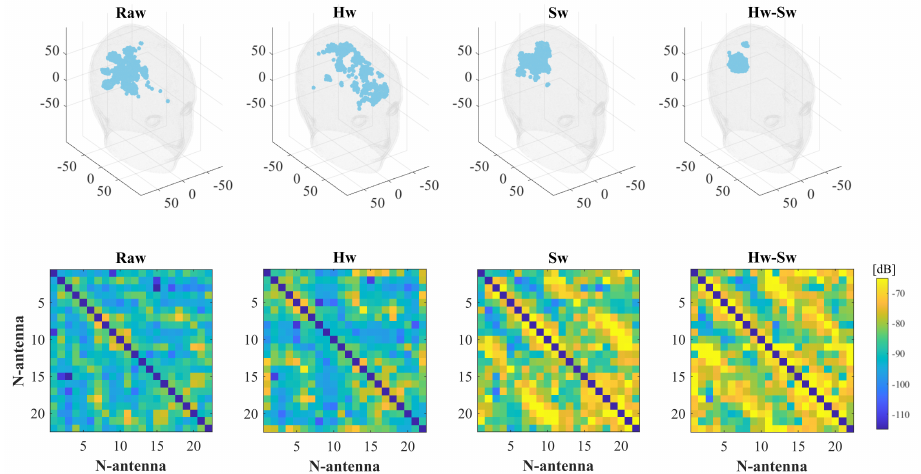
Figure 11. Calibration schemes applied to the ICH-MTP_1 case. Columns (from left to right): no calibration, Hw calibration, Sw calibration, and Hw and Sw calibrations. Top-row: normalized reconstructed dielectric contrast values above − 3dB (all the units are in mm); bottom-row: differential scattering matrices’ amplitude values in dB (the main diagonal is not